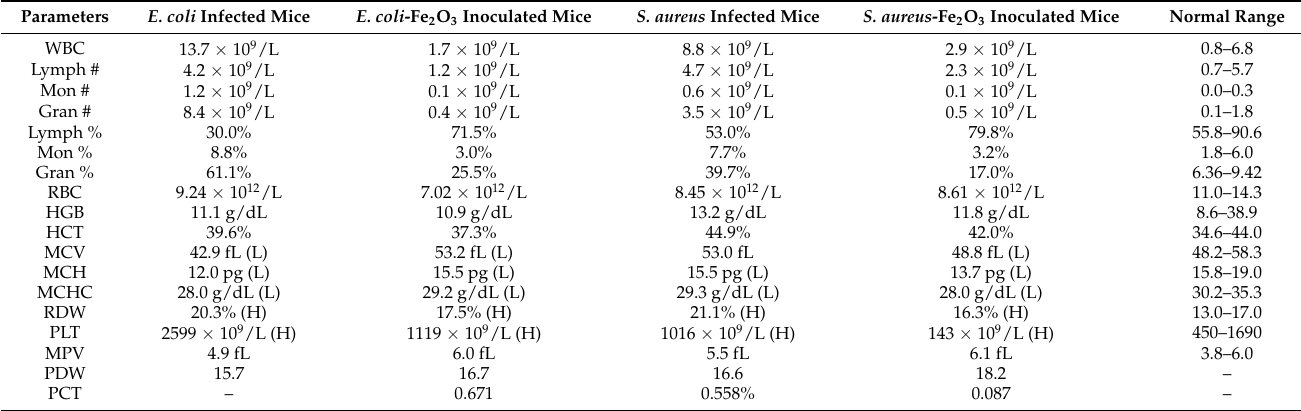
Table 1. Hematological analysis infected and treated mice